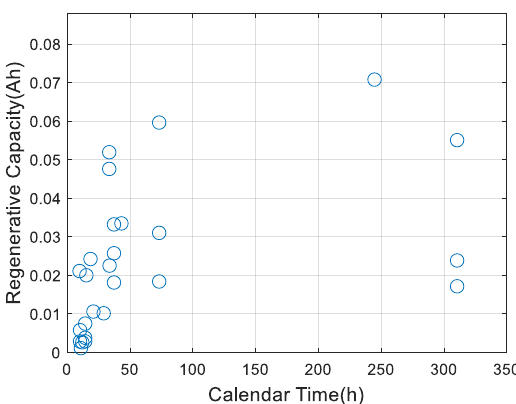
Figure 5. Relationship between capacity regeneration value and calendar